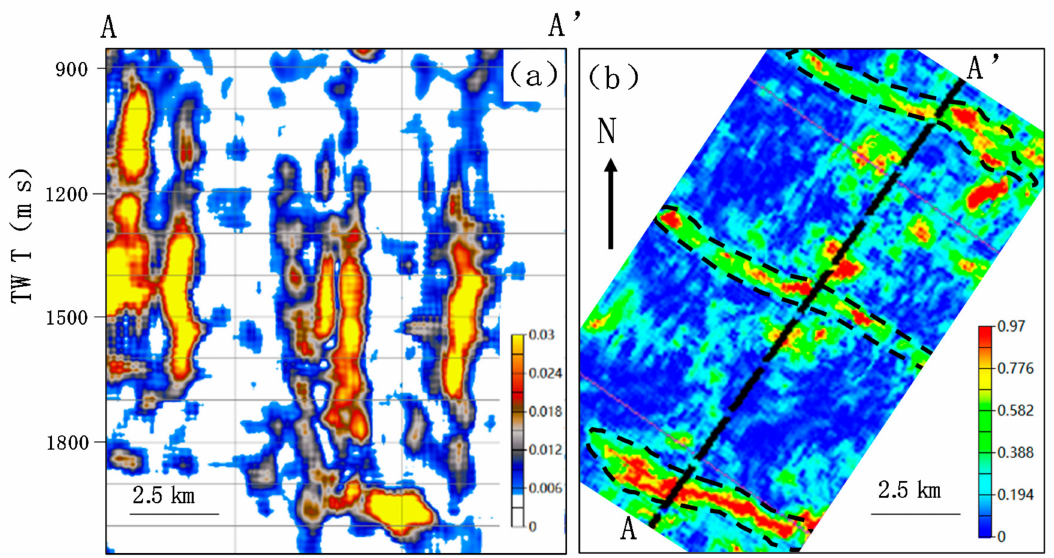
Figure 6. The strong anisotropic energy, showing the fractured reservoirs of the fault zones in the study area in a section ( a ) and in a planar plot ( b ) (the orange block shows the fractured reservoirs along the fault